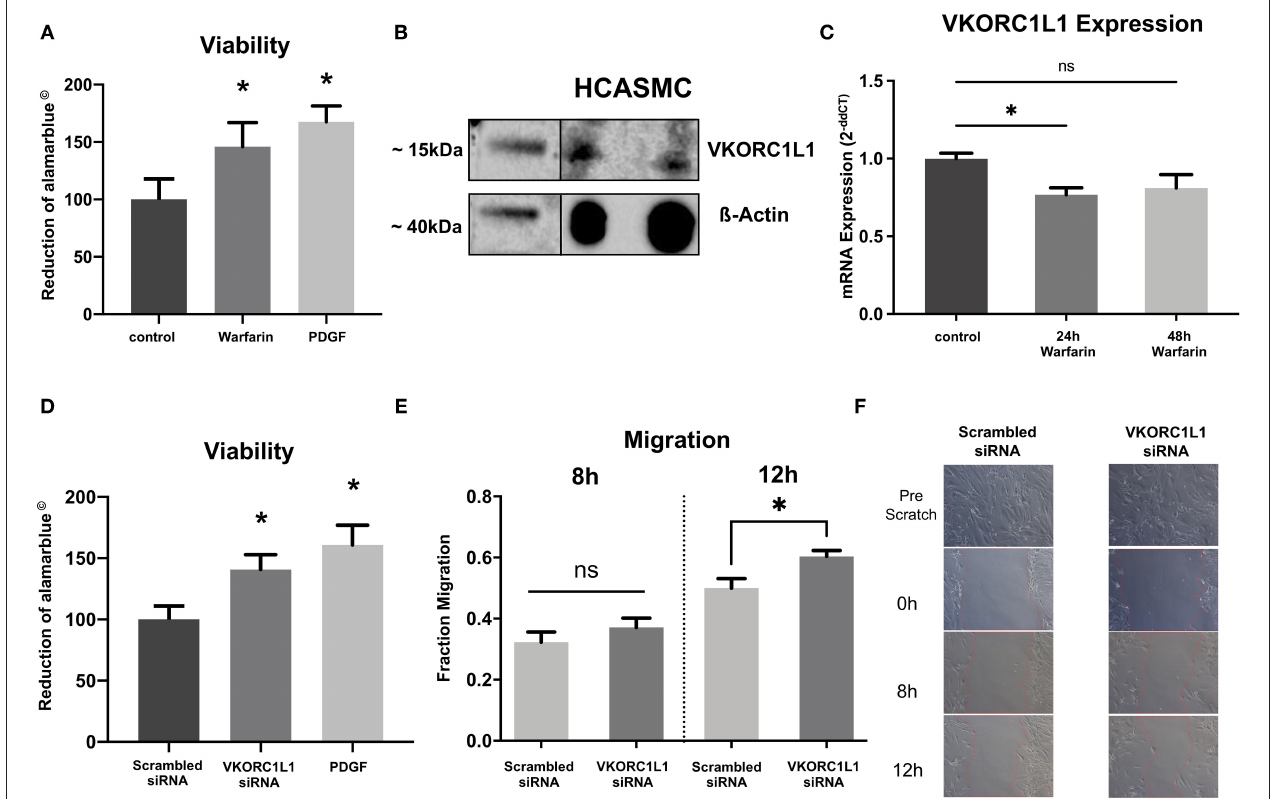
FIGURE 2 | VKORC1L1-downregulation enhances HCASMC viability and migration. (A ) Viability of HCASMC measured by alamarblue ® assay after treatment with 1 µ mol warfarin for 24h. (B) VKORC1L1 protein expression in untreated HCASMC visualized by western blot. ß-Actin was used as housekeeping protein. (C ) mRNA expression of VKORC1L1 in HCASMC after treatment with 1 µ mol warfarin for 24 or 48h. mRNA expression was measured by qPCR and quantified by the 2 − ddCT method. n = 5. (D) Viability of HCASMC measured by alamarblue ® after transfection of siRNAs directed against VKORC1L1 or a scrambled control. (E) Migration of siRNA-transfected HCASMC following a wound–scratch assay, measured by microscopic visualization after 8 and 12 hours. n = 7. (F) Representative pictures of migration. * p < 0.05. Data are presented as the mean ± SEM; * p < 0.05; one-way ANOVA + Bonferroni’s multiple comparison test for (A, C, D) .